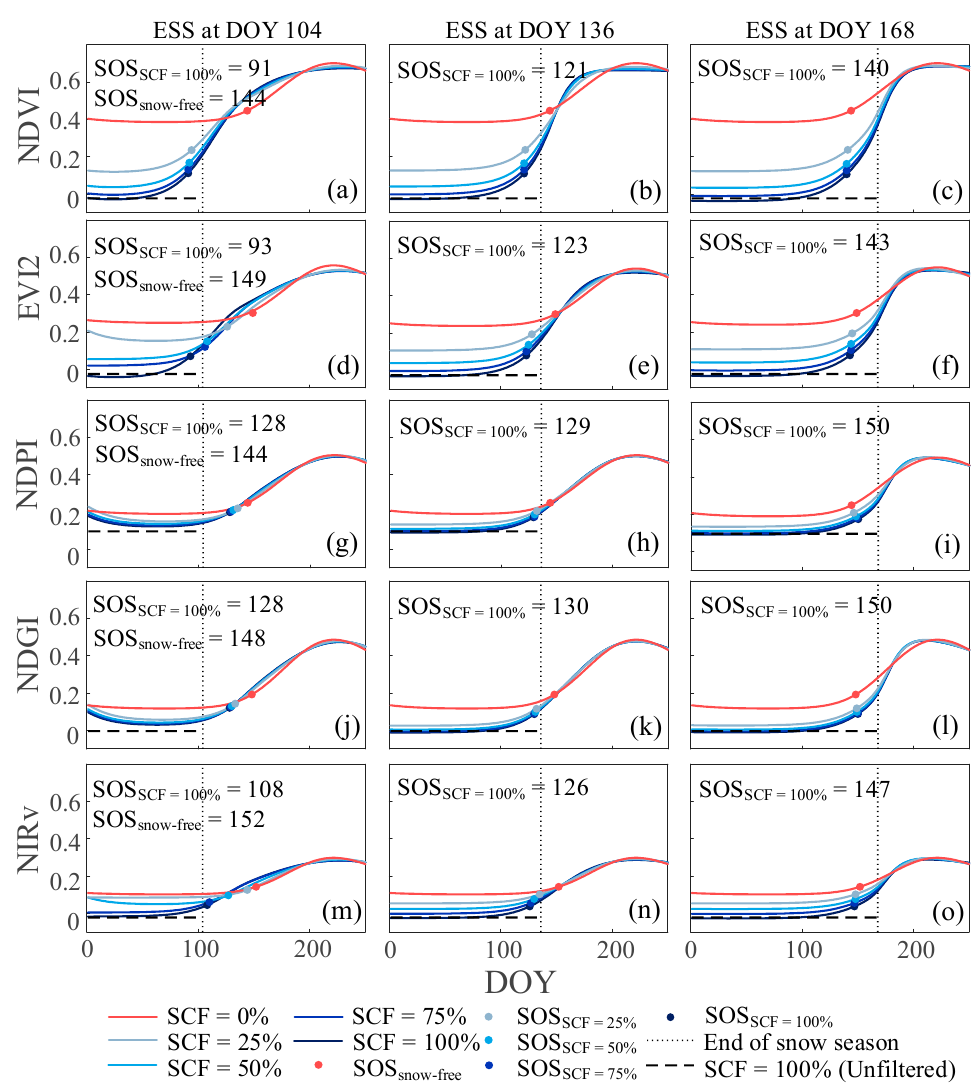
Figure 11. Time curves and the detected SOS of the five VIs under different SCF and ESS cases in experiments I and II. ( a – c ), ( d – f ), ( g – i ), ( j – l ), and ( m – o ) are the time curves of five VIs, for each of which three ESS cases at DOY 104, 136, and 168 and five cases of SCF = 0%, 25%, 50%, 75%, and 100% were plotted.